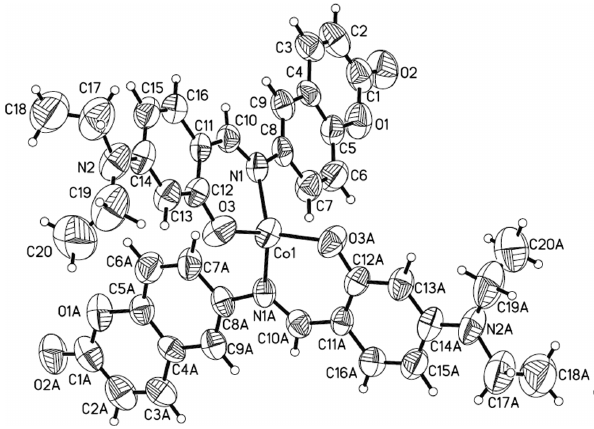
Table 1: Data collection and